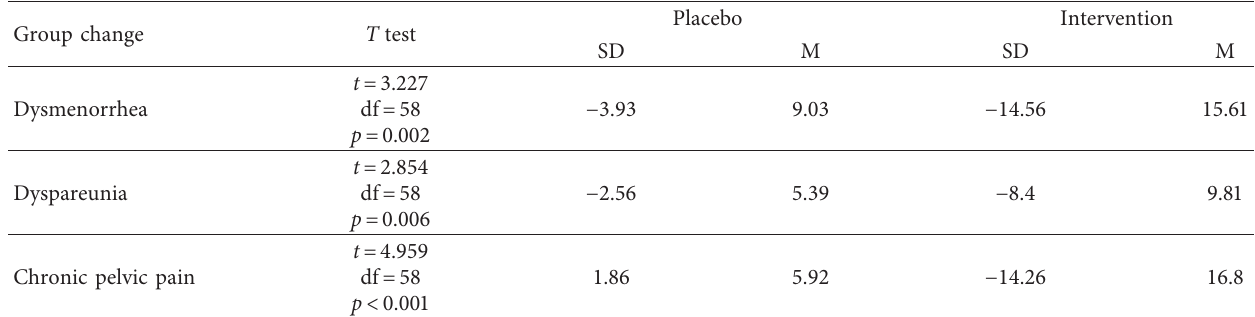
M, mean; SD, standard deviation. Table 4: Pain intensity score changes (dysmenorrhea, dyspareunia, and chronic pelvis pain) before and after treatment in treatment and placebo